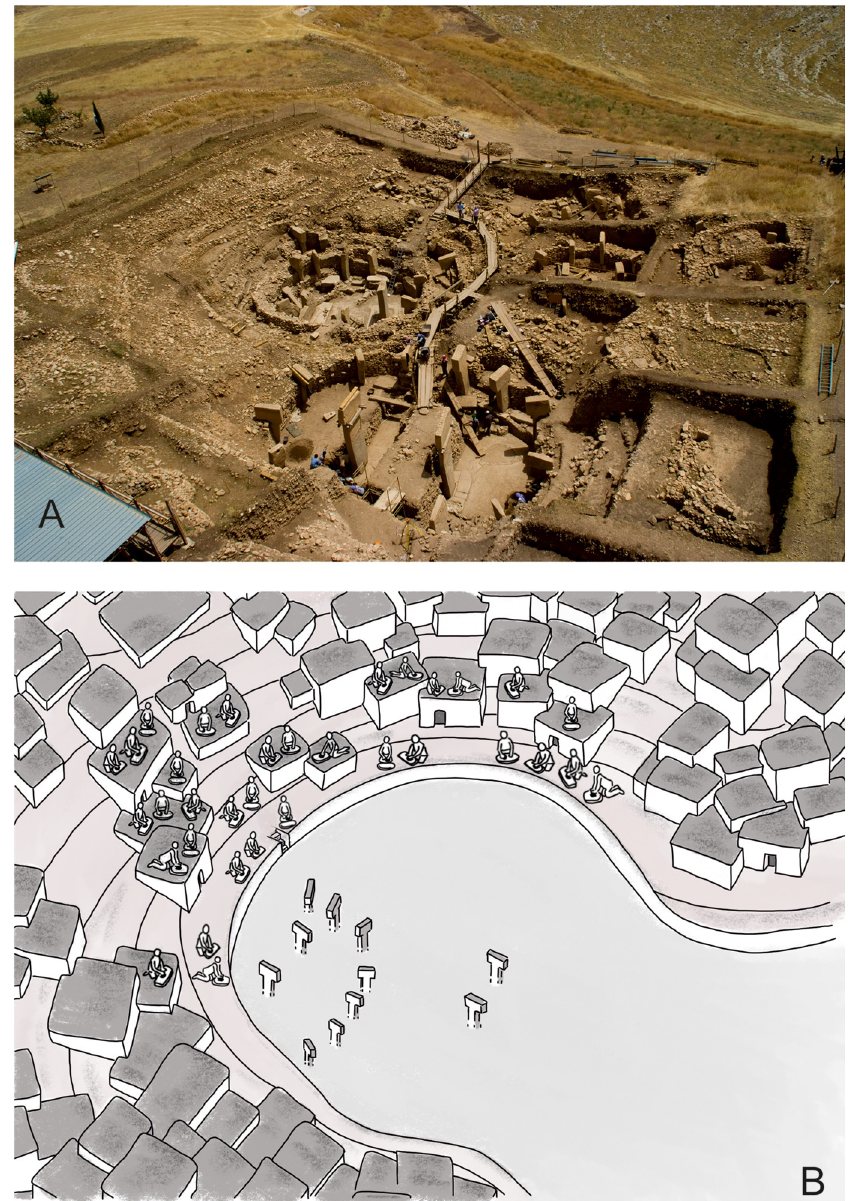
Fig 6. Go¨bekli Tepe, excavated features and reconstruction drawing. (A) Go¨bekli Tepe, excavations in the main excavation area, 2010. (B) Reconstruction drawing of communal work on the terraces and roofs with a view towards the monumental buildings (German Archaeological Institute, photo N. Becker, graphic J. Notroff, based on an architectural reconstruction by D. Kurapkat